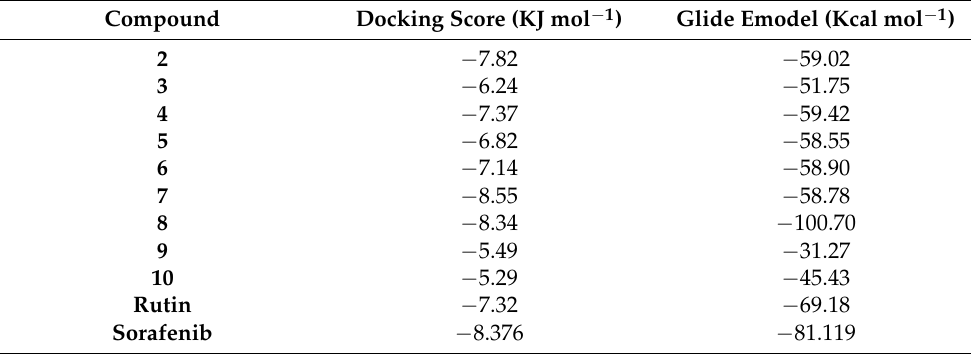
Table 3. The docking score and binding energy of the isolates and reference compound.